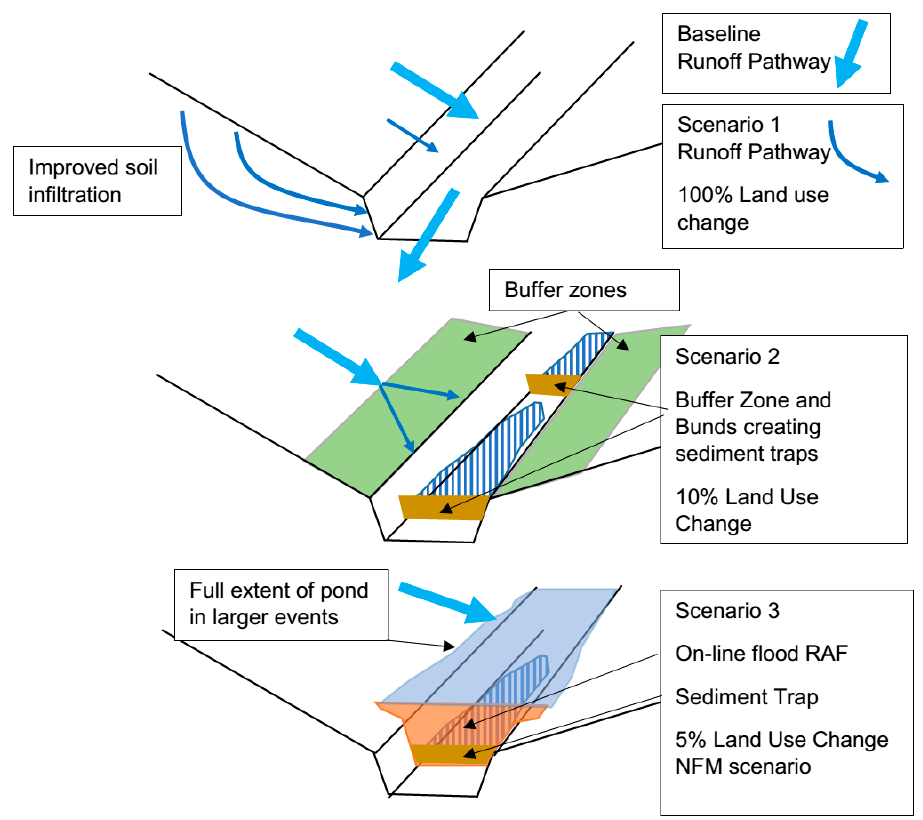
Figure 4. Schematic describing Runoff Pathways and design sketches of RAFs in Scenarios 1–3, and Runoff Pathways in the Baseline simulation. Note that Scenario 3 has a widened ditch eating into the buffer zone.